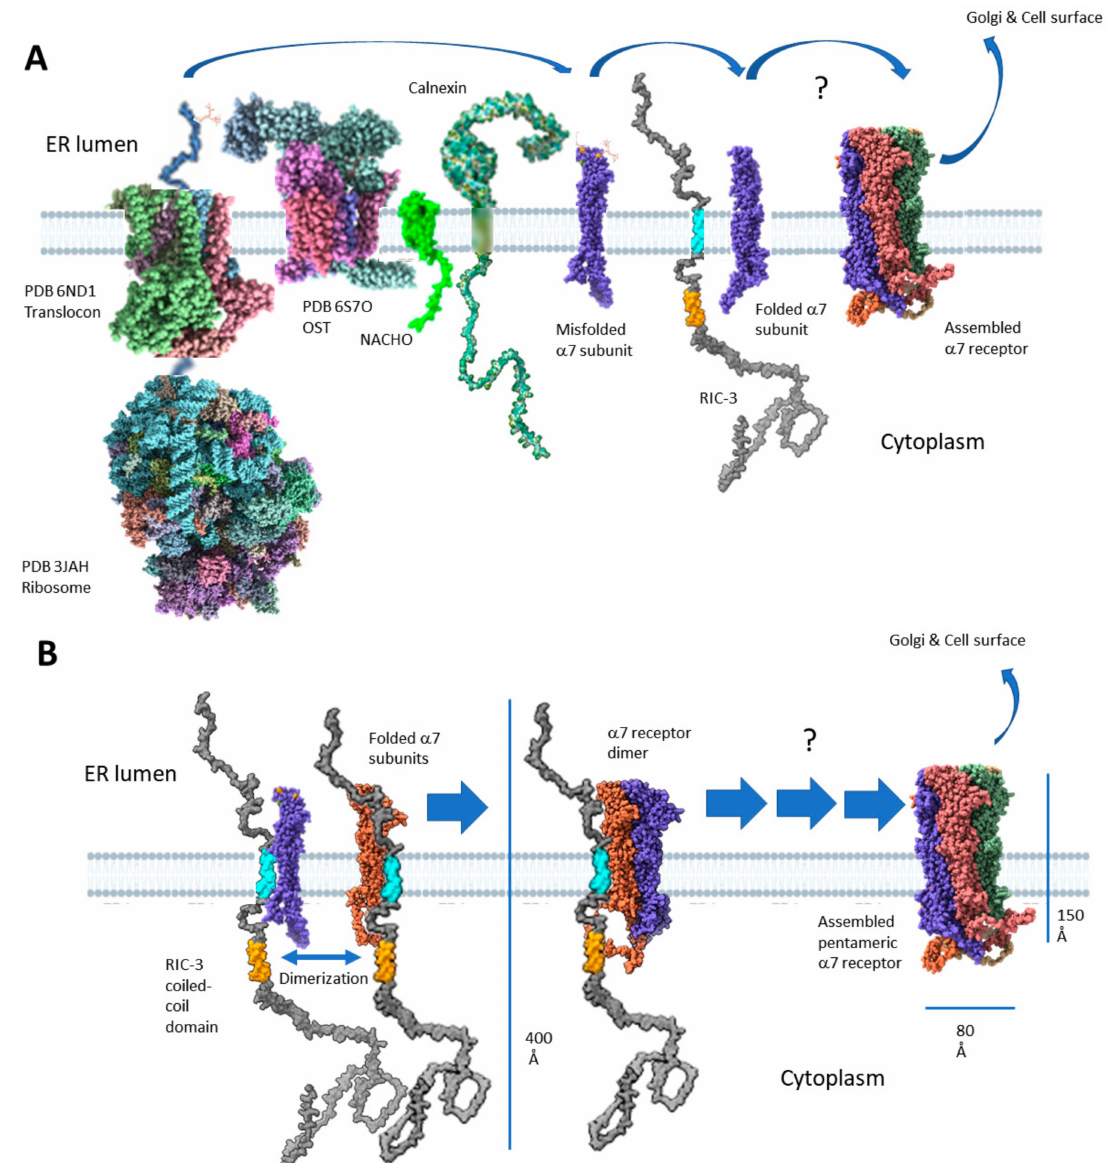
Figure 6. Two models from the literature on how RIC-3 helps assemble α 7 nAChRs. Panel ( A ) is based on Kweon et al. (Figure 7D in [23]) and shows cartoons of prominent ER proteins involved in the synthesis, folding and assembly of α 7 nAChRs. Cartoons are only approximately to scale and are based on the size of putative transmembrane domains crossing the membrane. The ribosome (PDB 3JAH) is artificially disconnected from the translocon (PDB 6ND1, yeast Sec complex) to show the growing translated α 7 chain (skyflower blue) going into the translocon channel. Oligosaccharide transferase (OST PDB 6S7O) attaches high mannose-type glycans to appropriate α 7 asparagine residues as the α 7 chain emerges from the translocon after removal of the α 7 signal peptide. According to Kweon et al. [23], human NACHO (lime green model from AlphaFold AF-Q53FP2-F1) does not directly contact the α 7 chain but interacts with both OST (through subunits ribophorins 1 & 2) and Calnexin (Multicolor model from AlphaFold AF-P27824-F1 and PDB 1JHN)). Calnexin interacts with misfolded α 7 chains (Purple) through incompletely processed glucose residues in the high mannose α 7 cores. RIC-3 (Gray chain from Alphafold AF-Q7Z5B4-F1) has its effects late in the folding process, and properly folded α 7 subunits form the basic pentamer that gets further processed in the Golgi apparatus before being trafficked to the cell surface. The putative RIC-3 transmembrane domain